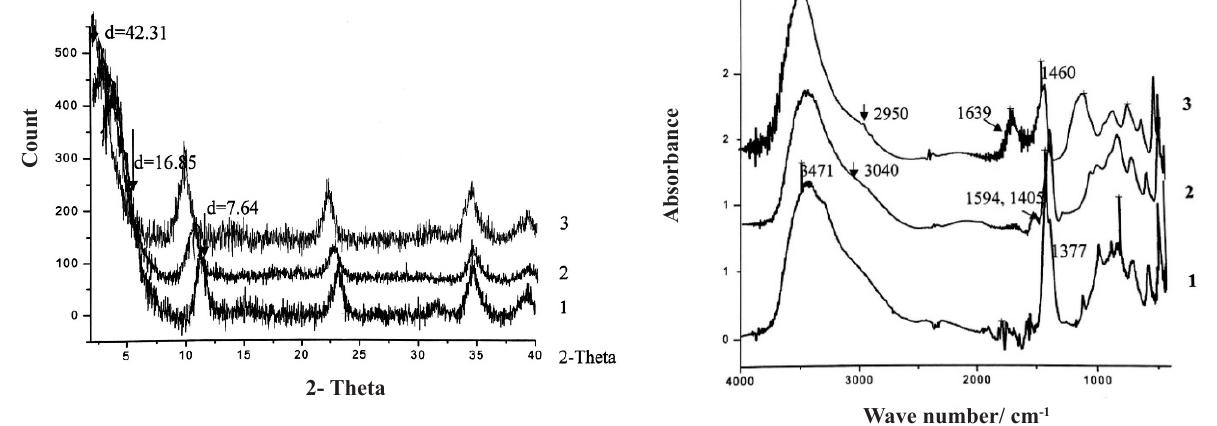
Figure 3.a: Powder XRD patterns of (1) Mg/ Al CO 32- LDH (2) Glutamate pillared LDH (3) Covalently linked trypsin within GP LDH